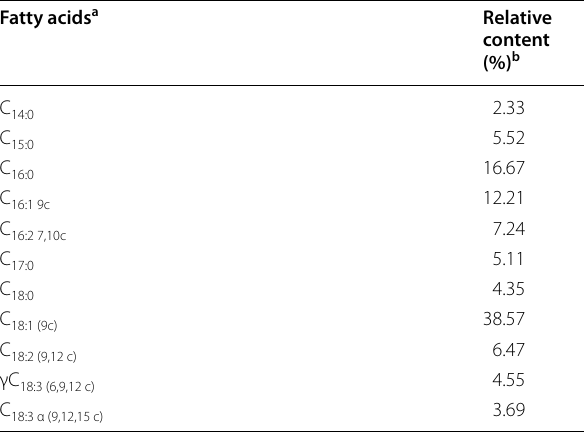
Table 5 Fatty acids composition of Pseudochlorella pringsheimii biodieselat 15 days of cultivation